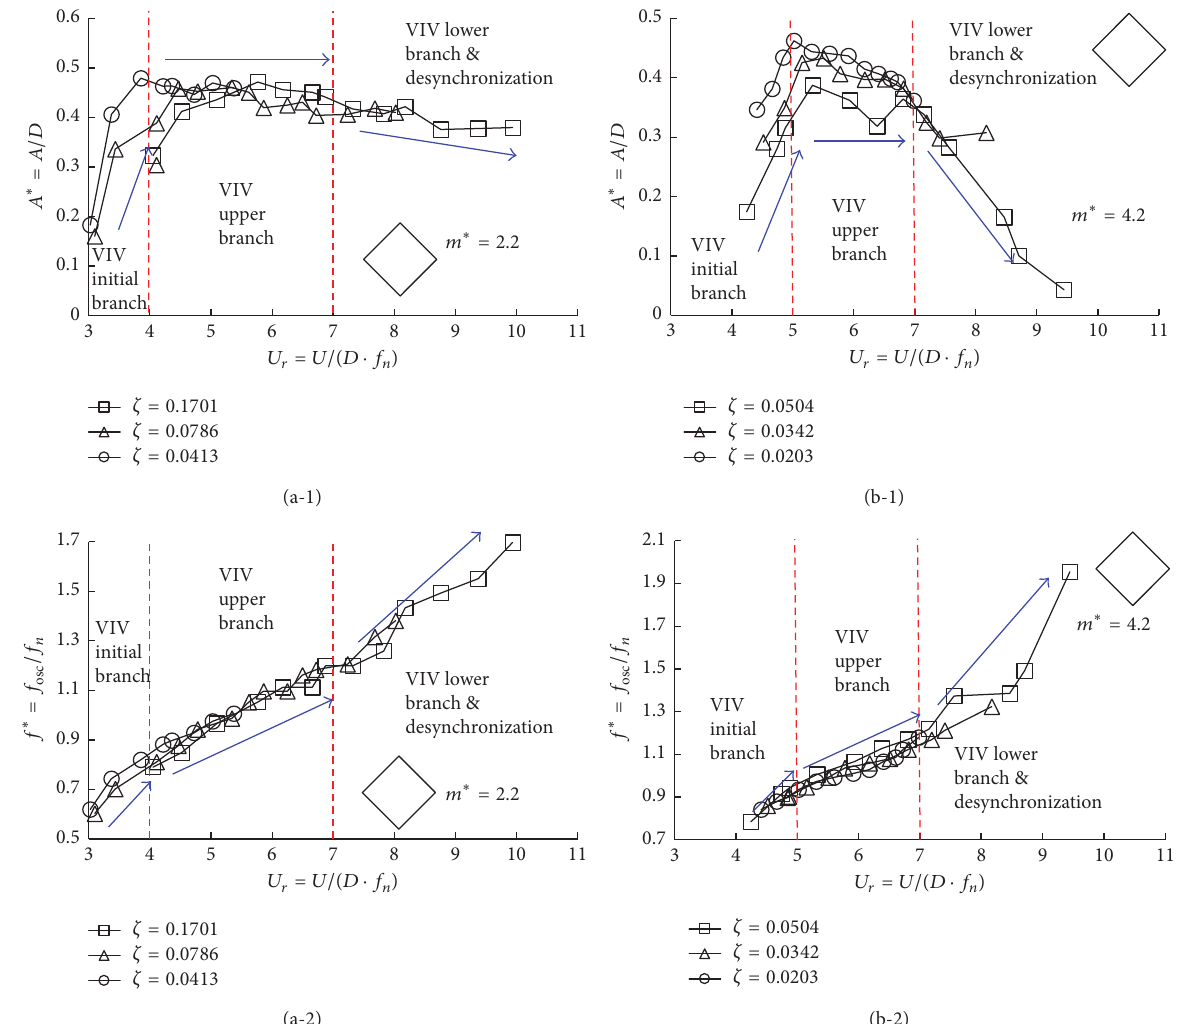
/𝑓 𝑈 = 𝑈/(𝑓 𝐷) ; damping ratios 𝜁 = 𝑐/2√𝑚 osc 𝑛 ; reduced velocity 𝑟 𝑛